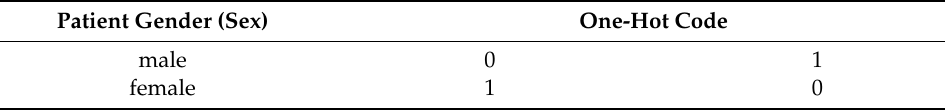
Table 1. A coding table for patient gender metadata.